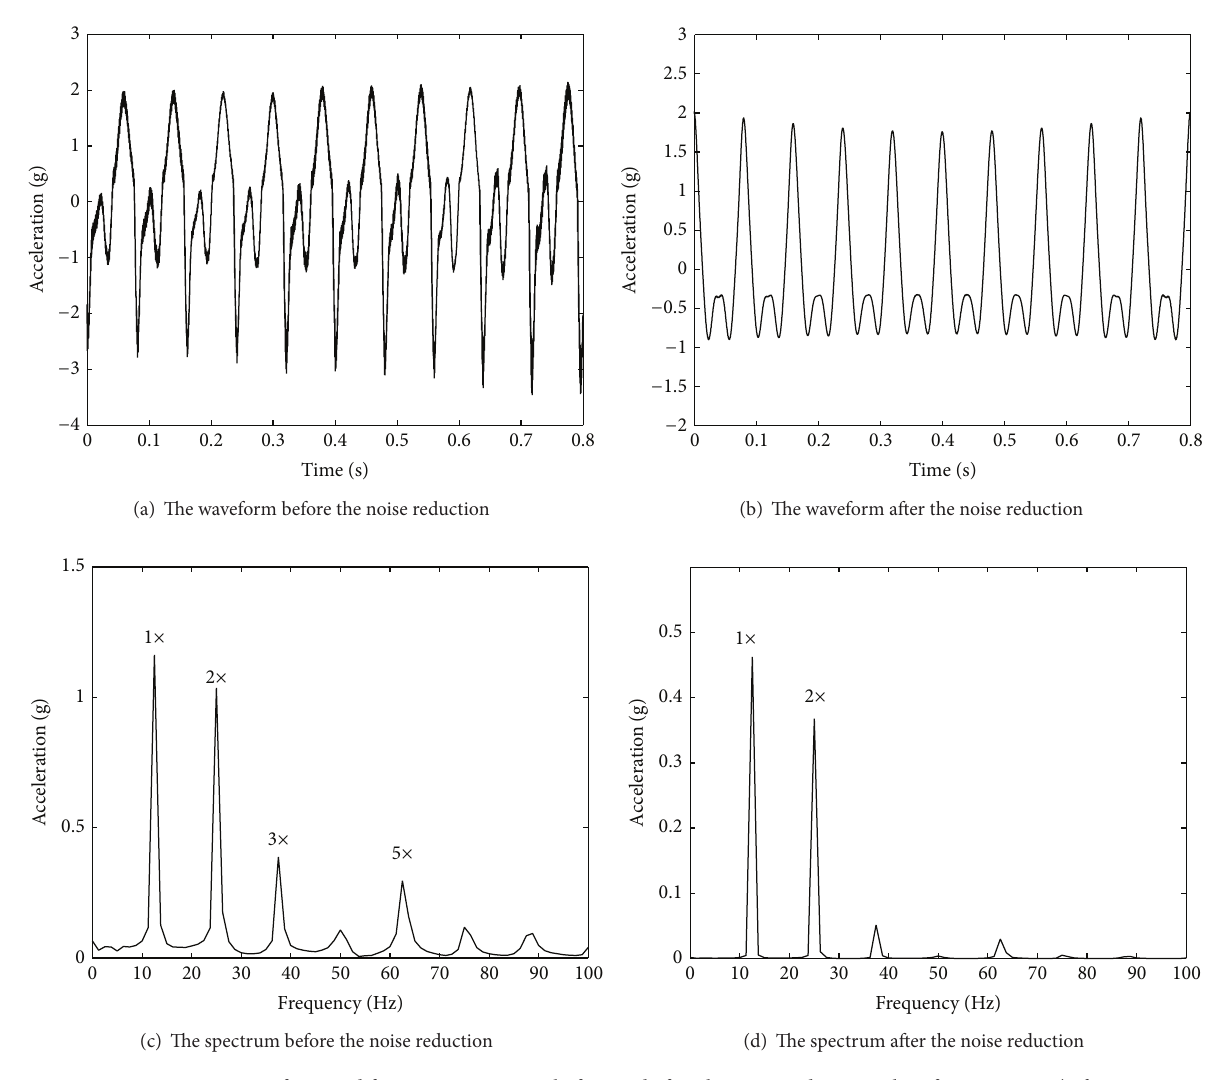
Figure 27: Waveform and frequency spectrum before and after the noise reduction when frequency is 1/2𝑓 𝑛